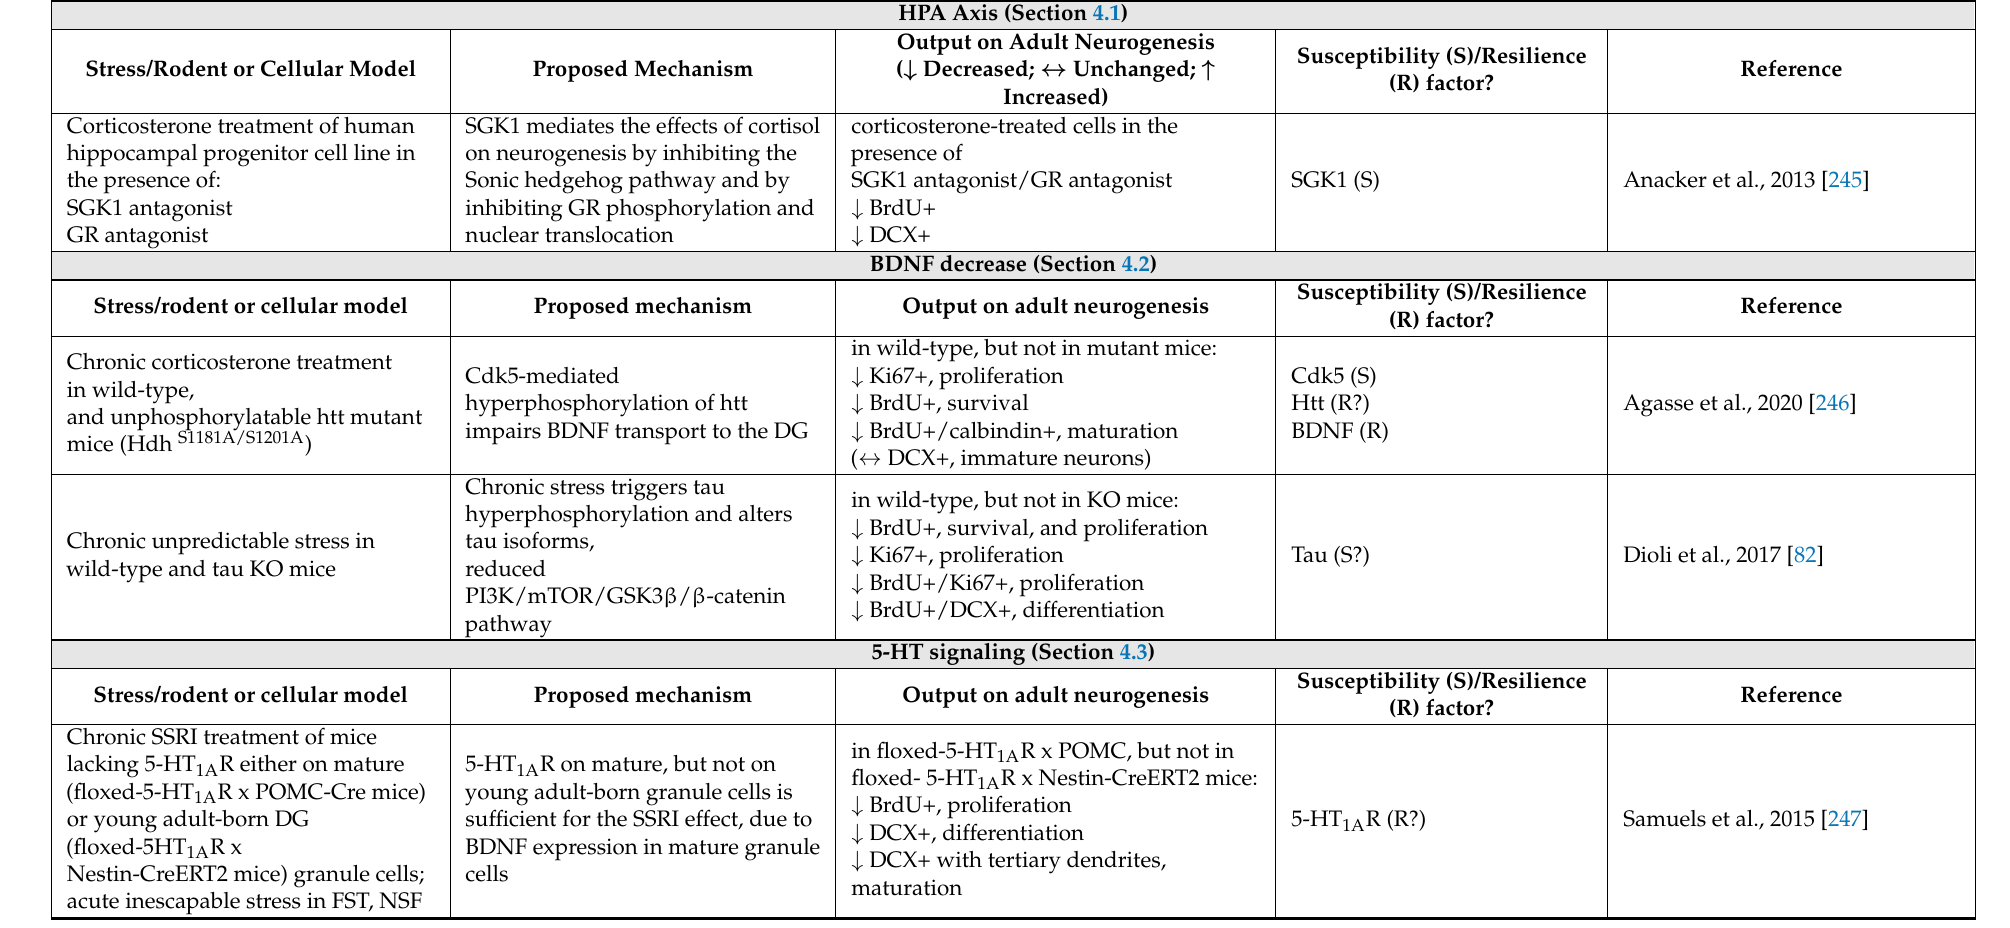
Table 2. Summary of key publications describing diverse mechanisms leading to stress-reduced adult hippocampal neurogenesis. HPA Axis (Section